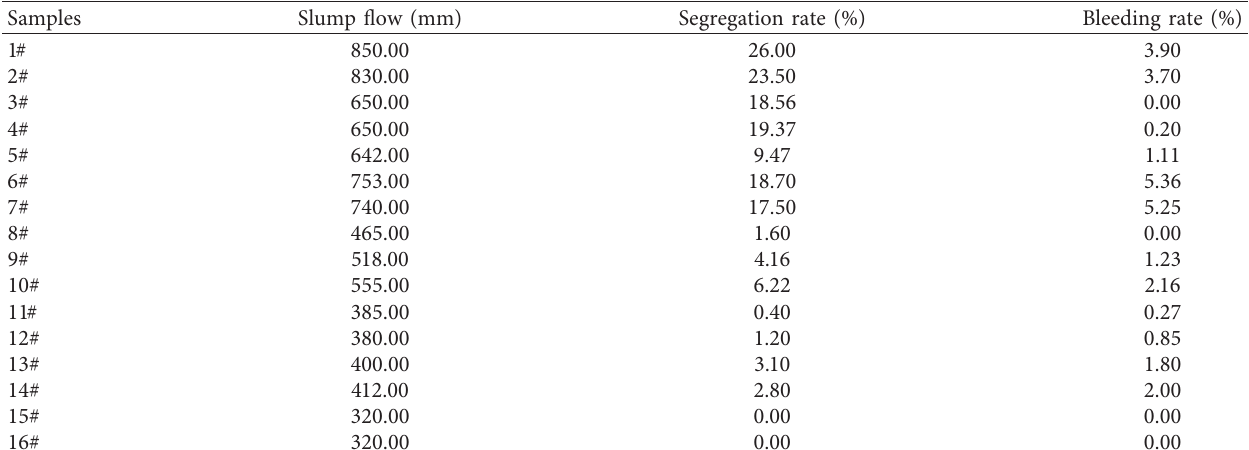
Table 4: Test results.